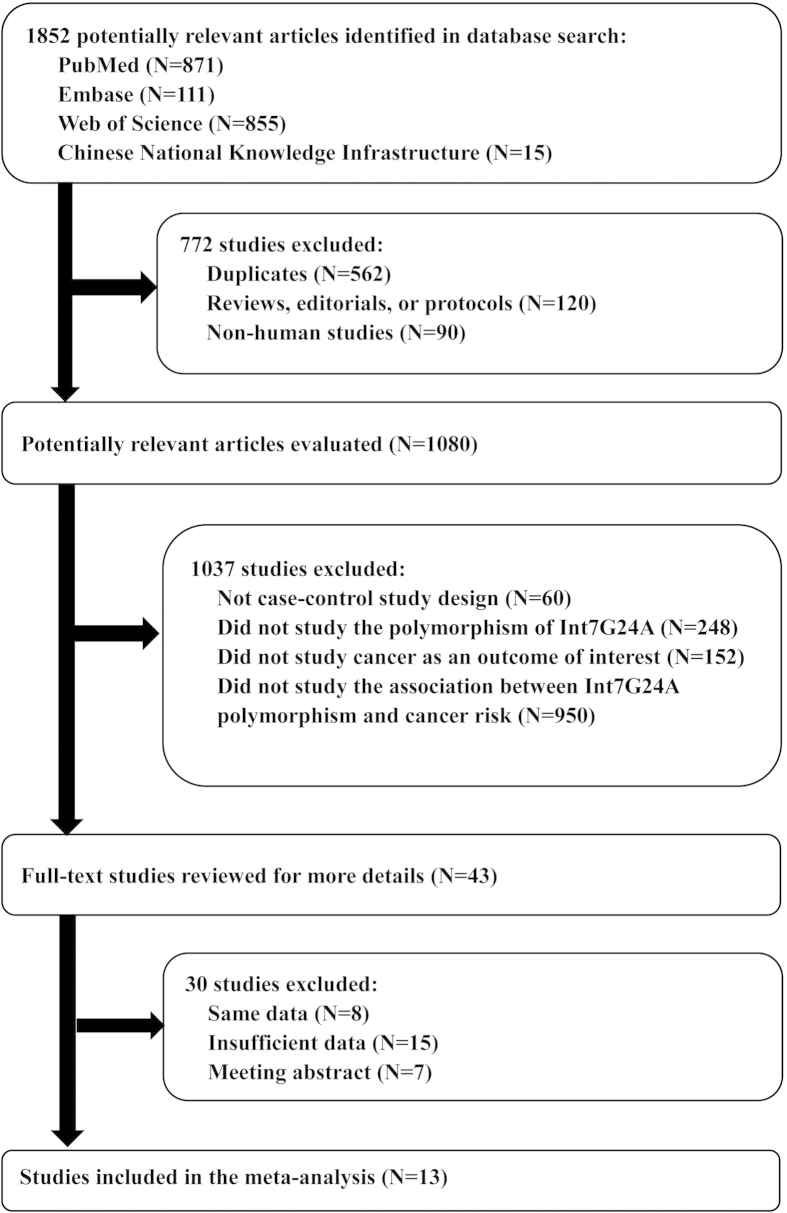
Flow chart of the study identification and selection progression.The terms “N” in the boxes represent the number of
corresponding studies. The term “same data” means
the studies which reported their results based on the same data. The term
“insufficient data” refers to the studies which did
not provide enough data for us to calculate the ORs and 95% CIs of the
association between Int7G24A polymorphism and cancer risk.